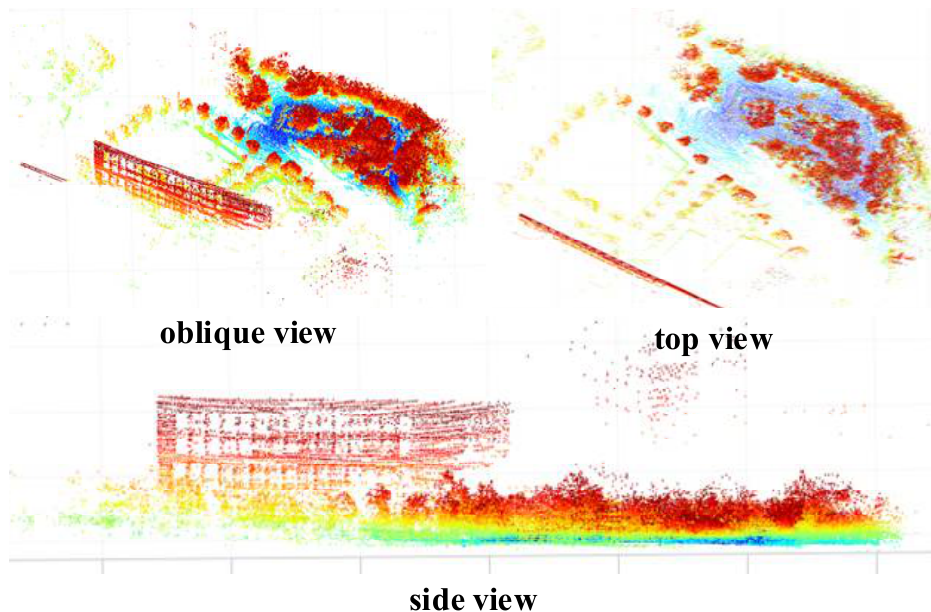
Figure 12. LiDAR point cloud mapping results.